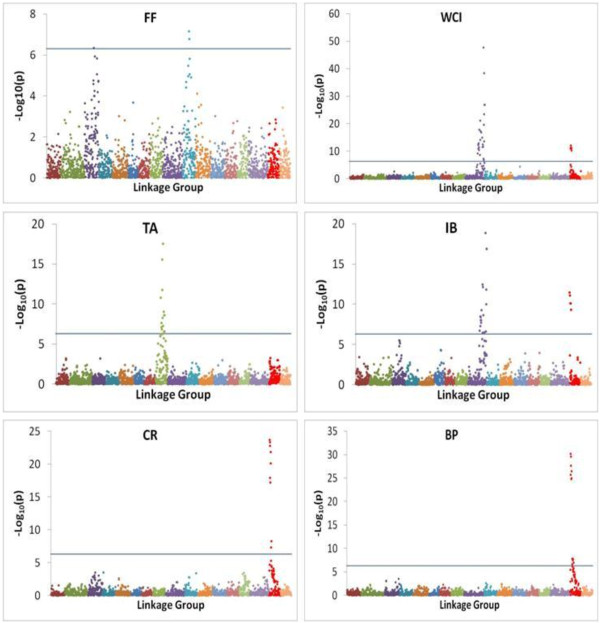
Manhattan plots of the –log10(p) values for various apple fruit traits (FF: fruit firmness; WCI: weighted cortical intensity; IB: internal browning; TA: titratable acidity; CR: fruit splitting; BP: bitter pit) from a genome-wide scan are plotted against position on each of 17 linkage groups (represented by different colours). Grey horizontal line indicates the genome-wide significance threshold.